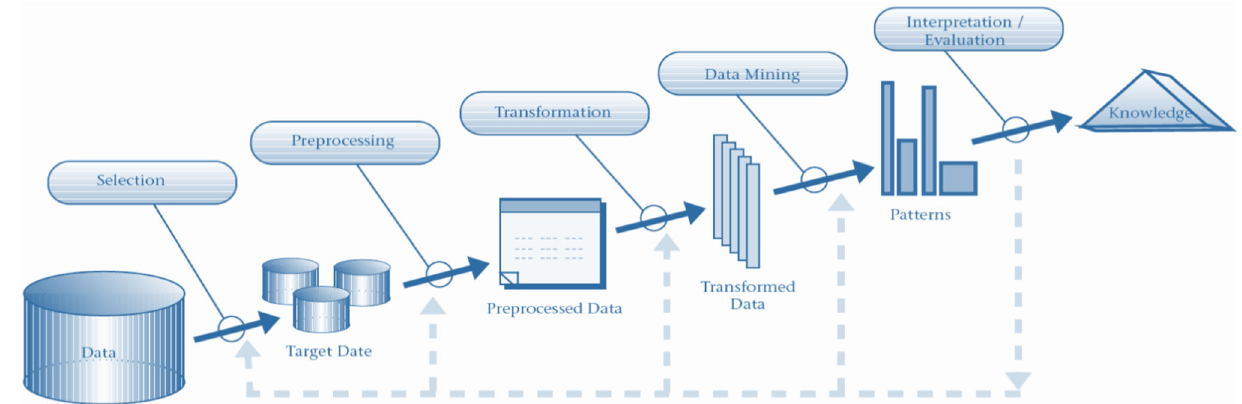
Fig. 1 The knowledge discovery